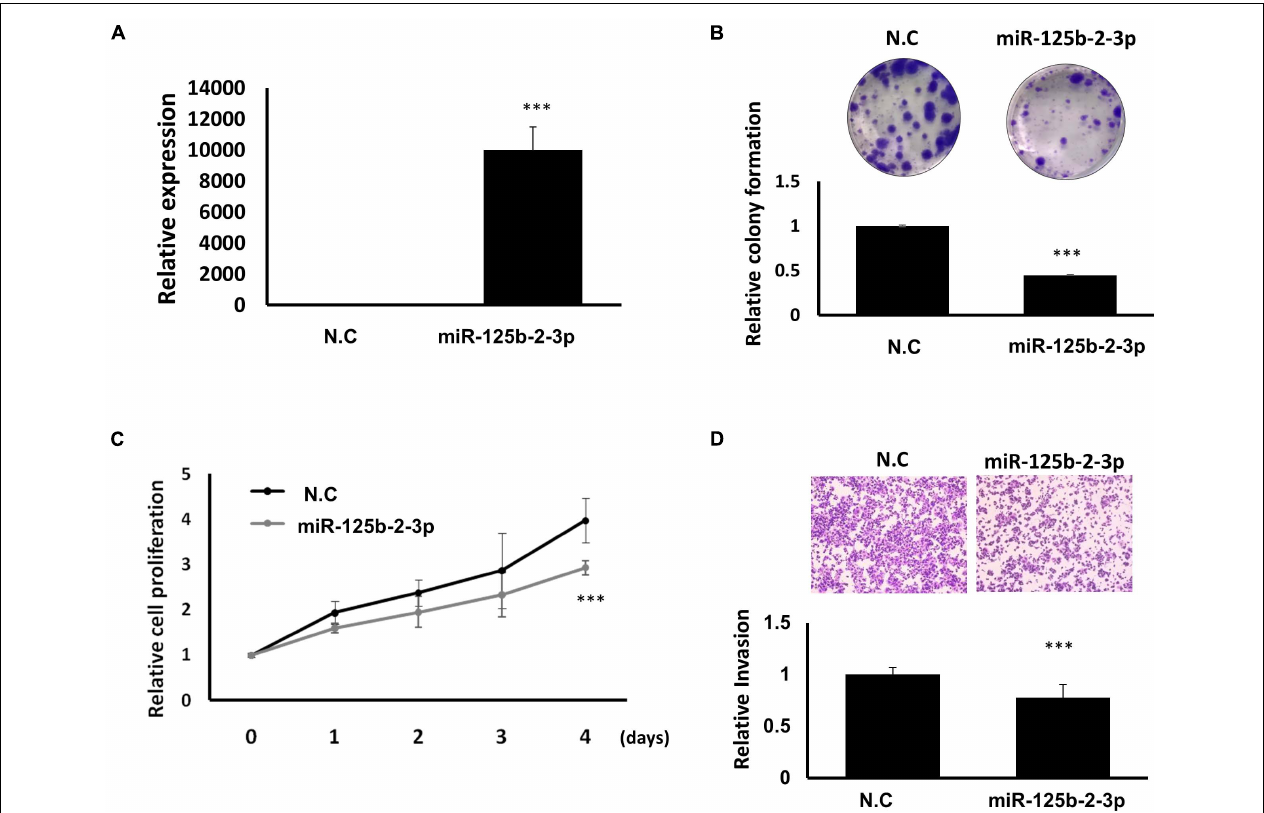
FIGURE 9 | Suppression of breast cancer cell growth and motility through miR-125b-2-3p expression. (A) Expression levels of miR-125b-2-3p examined in MDA-MB-231-IV2-1 cells after miR-125b-2-3p mimics transfection (real-time PCR). (B) Colony formation ability examined and quantified in MDA-MB-231-IV2-1 cells with or without miR-125b-2-3p overexpression. (C) Cell proliferation of MDA-MB-231-IV2-1 cells assessed after miR-125b-2-3p transfection for various time periods. (D) Invasion capability assessed using the transwell assay in MDA-MB-231-IV2-1 cells transfected with miR-125b-2-3p and the scramble control. The cell images of a representative experiment are displayed. The values quantified using Ascent are in the graph. Data are reported as the numbers of invading cells relative to the controls (means ± SD). All experiments were carried out in triplicate. Using Student’s t -test to analyze our data and p < 0.05 was considered significant (* p < 0.05, ** p < 0.01, and *** p <